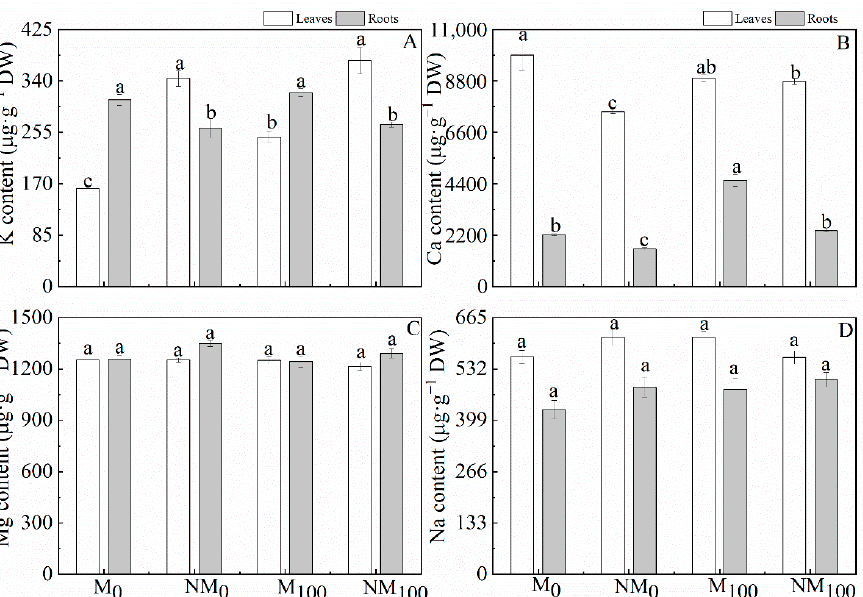
Figure 6. Changes in the contents of potassium (K, ( A )), calcium (Ca, ( B )), magnesium (Mg, ( C )), sodium (Na, ( D )) in leaves and roots of Neva irrigated with or without magnetized water following exposure to 0 or 100 µ mol · L − 1 cadmium stress. Values are the means ± SE of at least three replicates. Different lowercase letters indicate significant differences among the four treatments at the 0.05 level in leaves and roots.